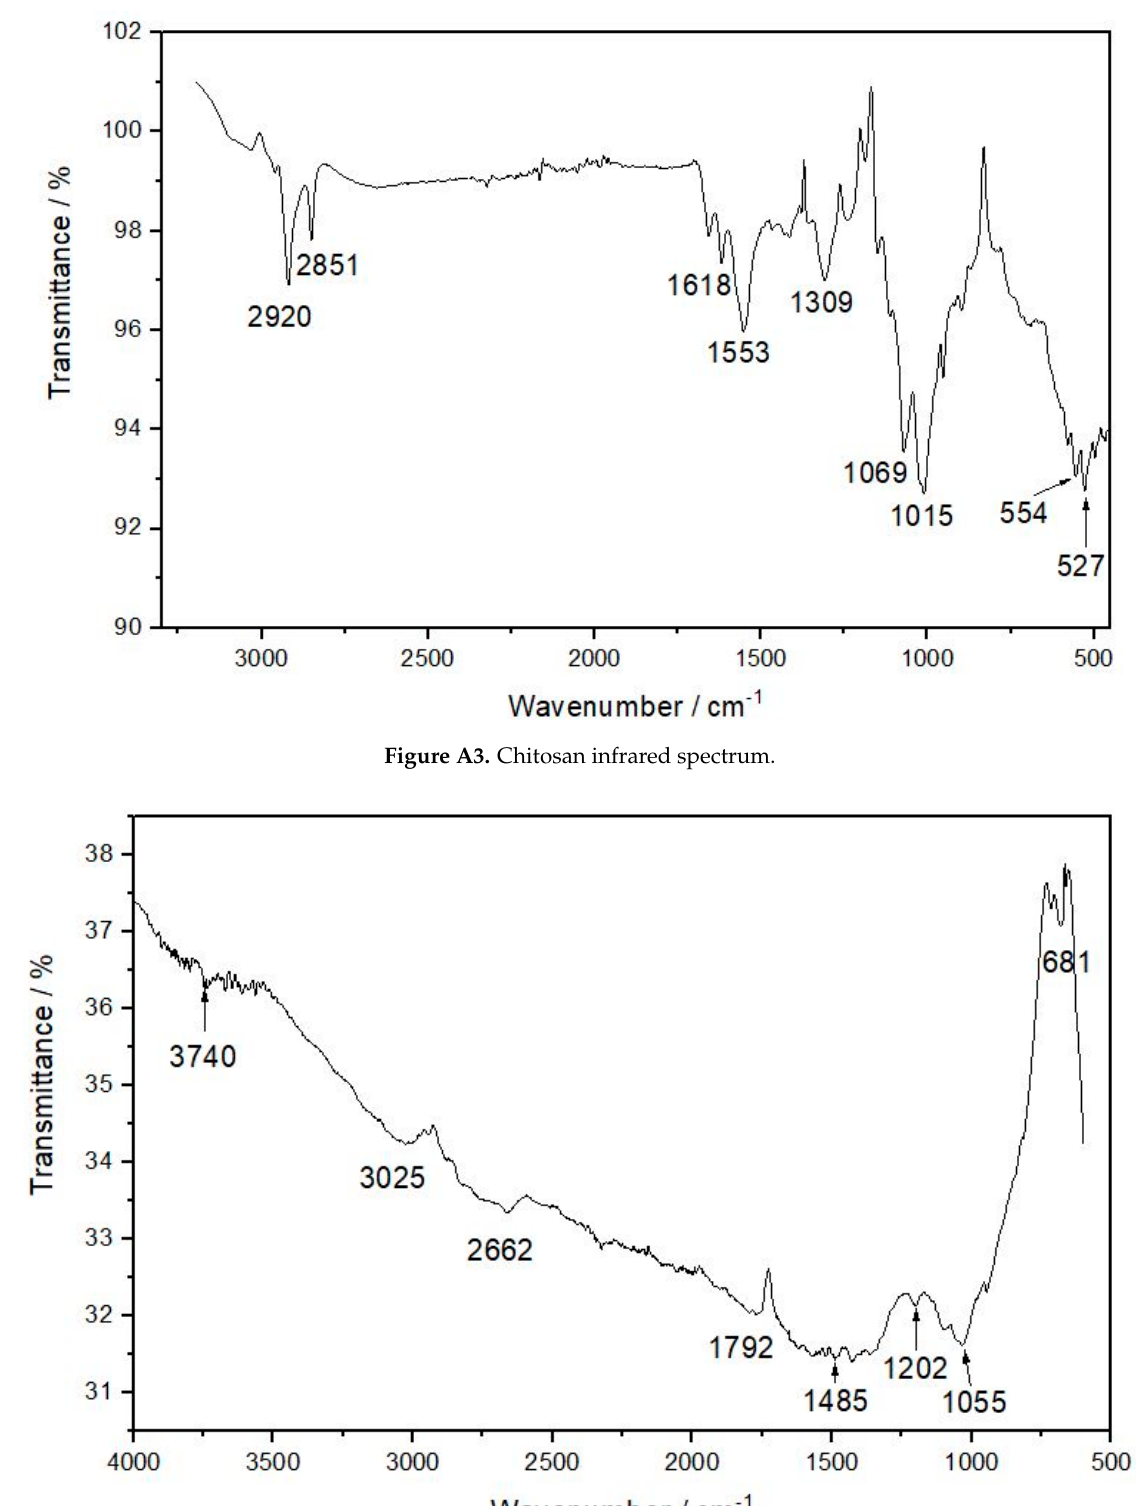
Figure A2. Erlotinib infrared spectrum.